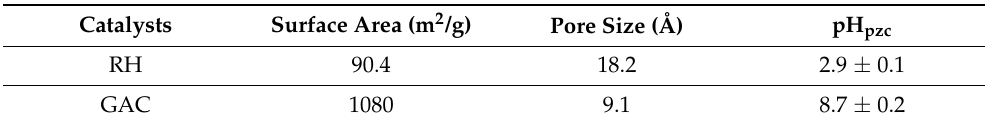
Table 3. RH and GAC